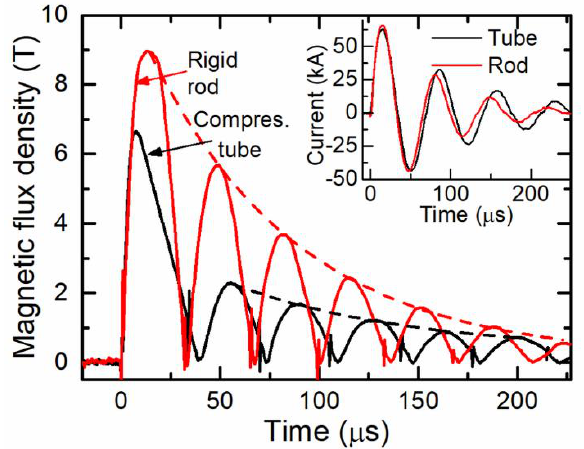
Figure 2. Magnetic field dynamics between the field shaper and the flyer part. The red curve marks the rigid rod; the black curve marks the 1.5 mm thick Al tube. Inset: the discharge current during tube compression is shown by the black line; during experiments with a rigid rod, by the red line.